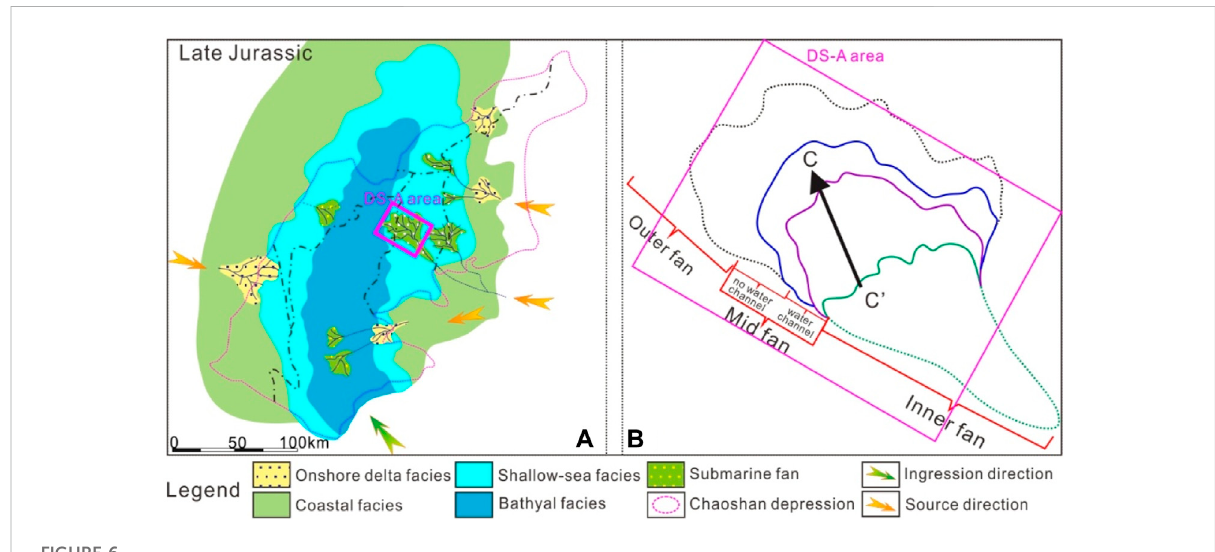
FIGURE 6 Sedimentary facies map in the Chaoshan Depression. (A) Map of the Late Jurassic sedimentary facies in the Chaoshan Depression; (B) construction of submarine fan.